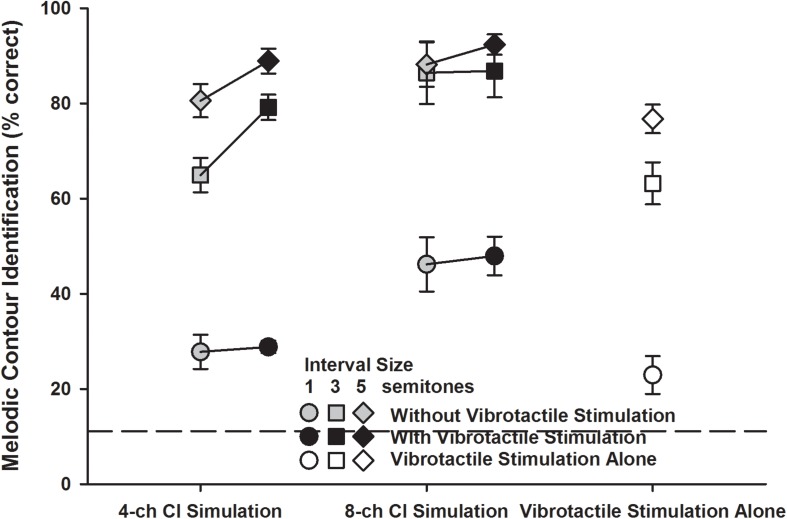
Melodic contour identification scores for the 1-, 3-, and 5-semitone intervals (circles, squares, and diamonds, respectively) with the 4- or 8-channel CI simulation (left and middle line plots, respectively) with or without vibrotactile stimulation (black and gray symbols, respectively) or with vibrotactile stimulation alone (white symbols). Symbols represent the mean, while error bars represent the standard error across participants. The horizontal dashed line indicates the chance performance of 11% correct.